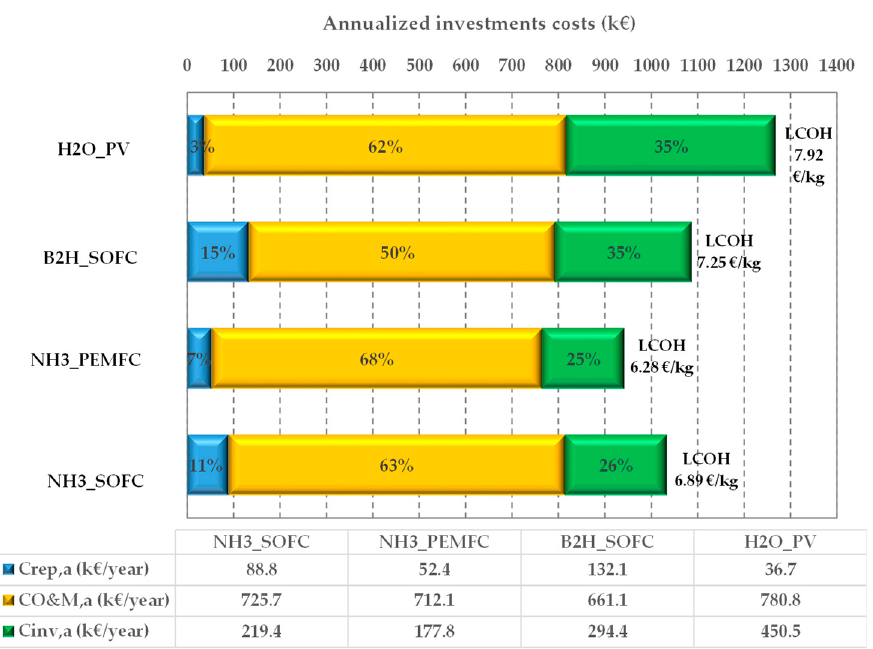
Figure 7. LCOH and annualized costs incidence for the proposed on-site HRS plants.